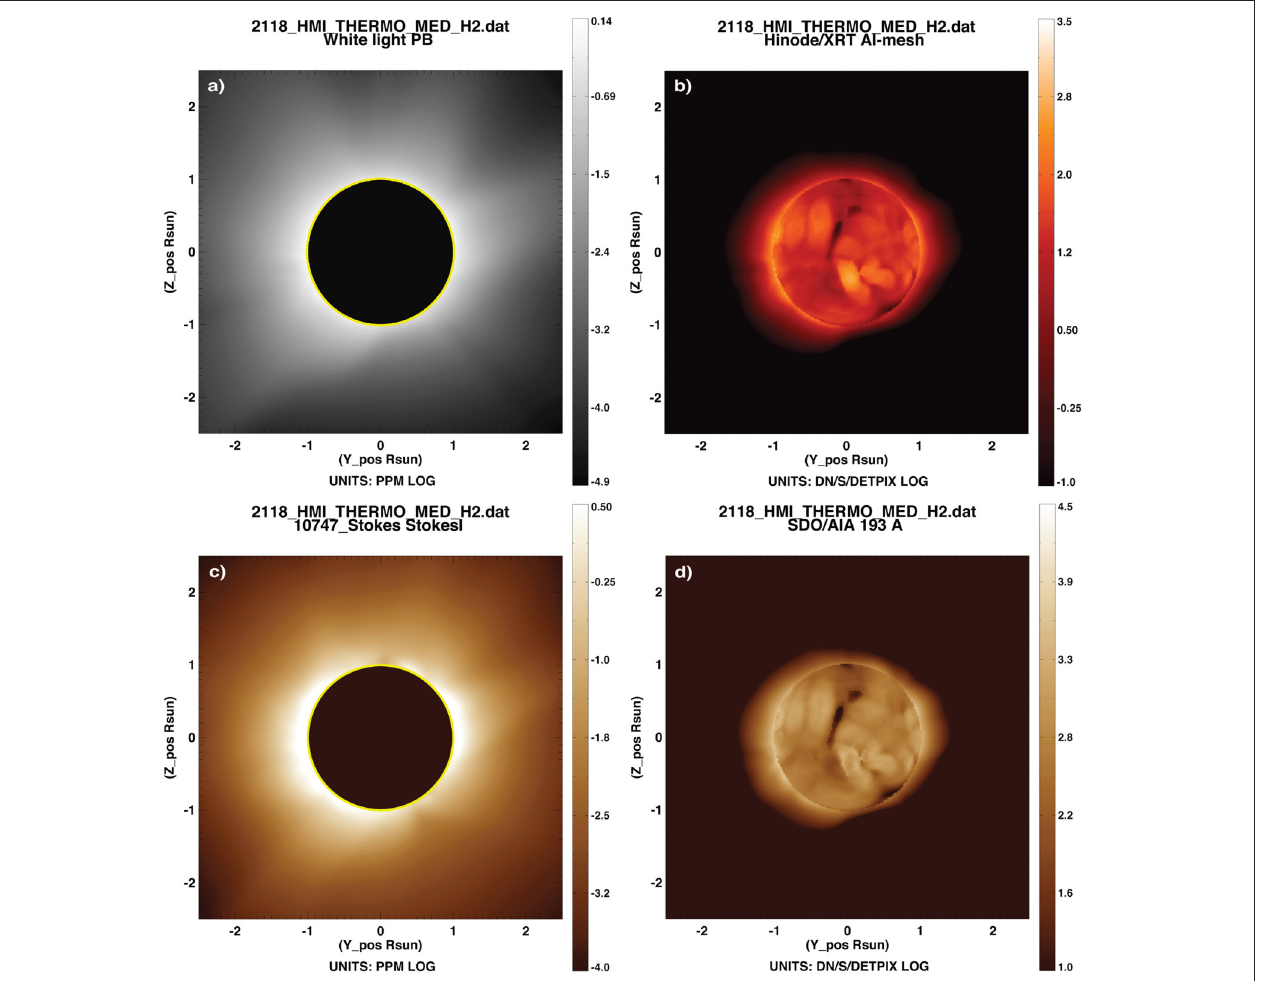
FIGURE 4 | Figure showing MAS synthetic data. (A) pB (see Section 3.1). Plot obtained via widget as in Figure 2 but selecting pB via the Observables menu, or alternatively via FORWARD line command for_drive,'psimas',date='2012-01-04',xxmin=-2.5,xxmax=2.5,yymin=-2.5,yymax=2.5,units='PPM' . (B) XRT Al-Mesh line (see Section 3.2). Plot obtained as in (A) with removal of units keyword and addition of /xrt,line='AL-MESH',usecolor=3 . (C) (infrared) Fe XIII 1074.7 Å intensity (see Section 3.4). Plot obtained as in (A) with additional keyword /comp,ngrid=256,ngy=256 . (D) (EUV) Fe XIII 193 Å intensity